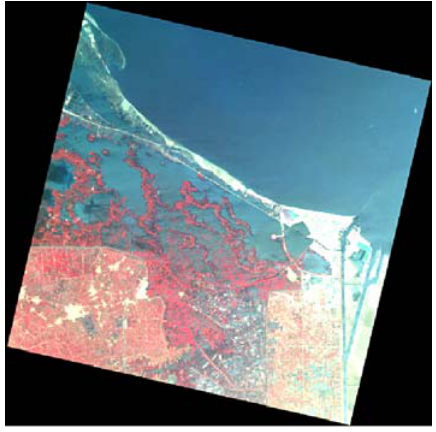
Figure 5. Egyptsat-1 image before and after atmospheric